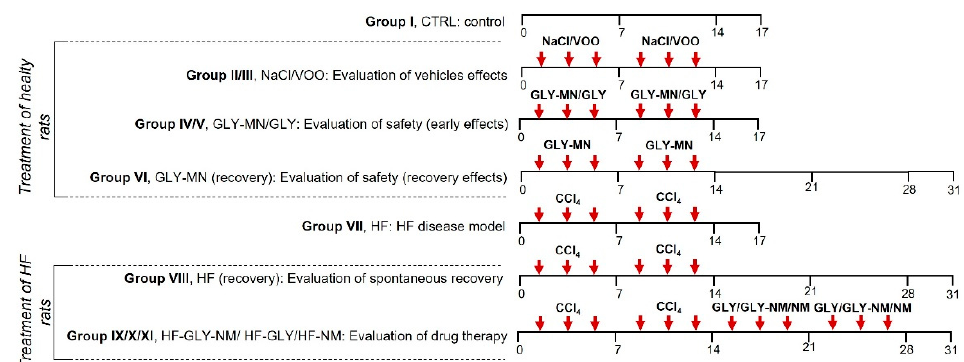
Figure 1. Schematic representation of the experimental groups. The horizontal axis indicates days of treatment and the last number on the horizontal axis is the day of the animal sacrifice. Arrows indicate intraperitoneal injections and the drug and/or solution administered (NaCl: sterile 0.9% NaCl; VOO: sterile virgin olive oil; GLY-MN: encapsulated LY2157299; GLY: free LY2157299; CCl 4 : CCl 4 , 40% in sterile virgin olive oil.